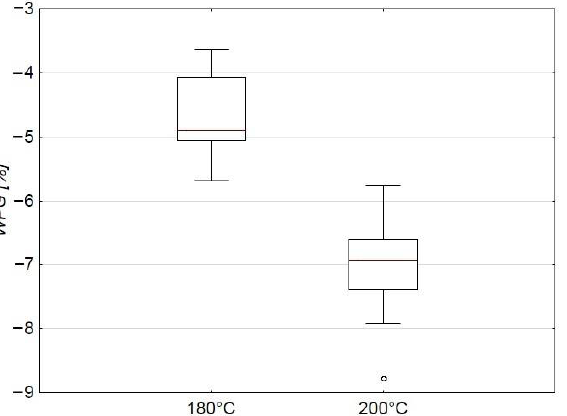
Figure 8. Weight loss after thermal modification in comparison to the unmodified specimens. ◦ — outlier